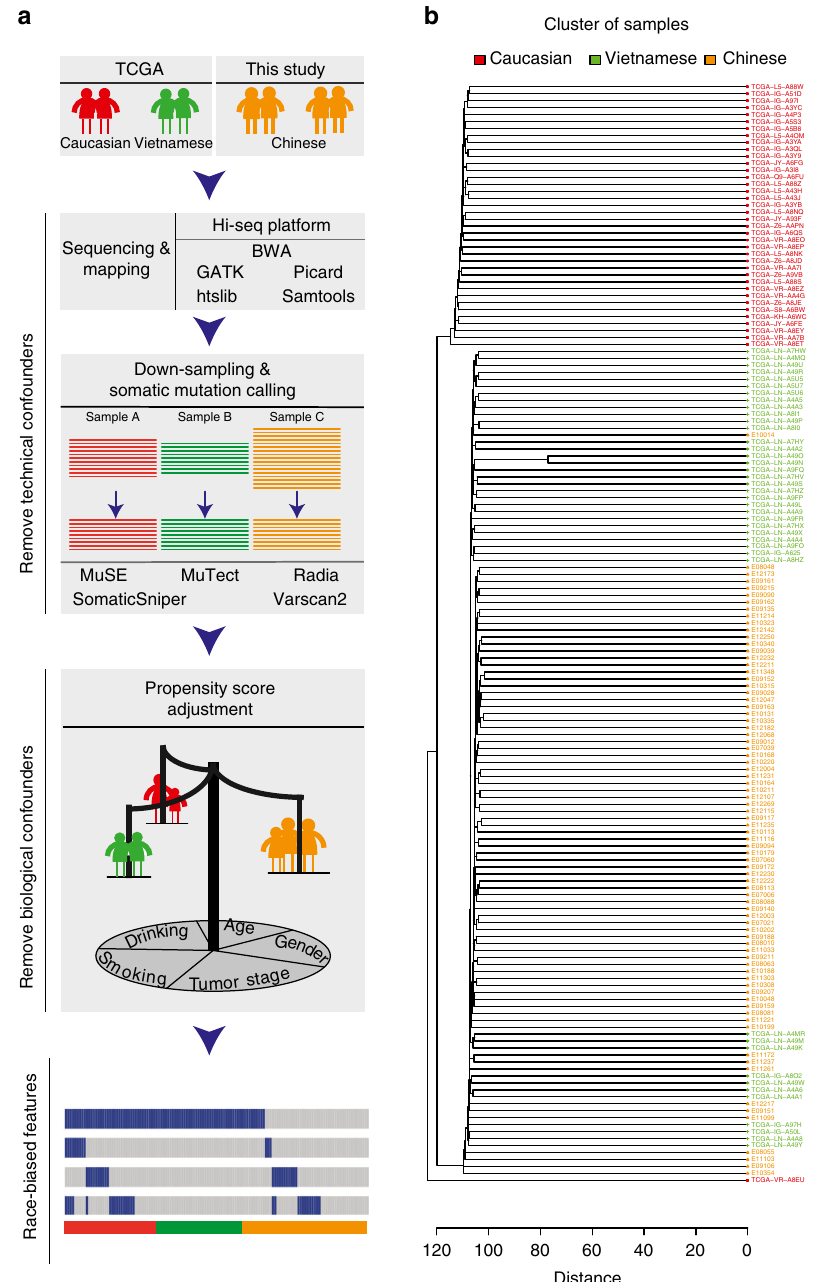
Fig. 1 Schematic representation of the analytic strategy. a ESCC whole-exome sequencing data of three patient cohorts, Caucasian, Vietnamese and Chinese, were respectively obtained from this study and TCGA. Our strategy includes two major steps to remove confounders. To remove technical confounders, we applied the same procedure to process sequencing reads generated from the Hi-seq sequencing platform. We then performed downsampling to balance the depth of coverage among the three cohorts, followed by a stringent method to call somatic single-nucleotide mutations using multiple mutational callers. Second, to remove biological confounders, we calculated propensity scores, reweighted samples in the cohorts, and compared gene mutation frequencies between two balanced cohorts. We considered fi ve biological factors (age at diagnosis, gender, tumor stage, smoking history, and alcohol consumption history) in the propensity score adjustment. b Hierarchical clustering pattern of patient samples by common SNP status in the exonic regions. Asian patients and Caucasian patients form two distinct